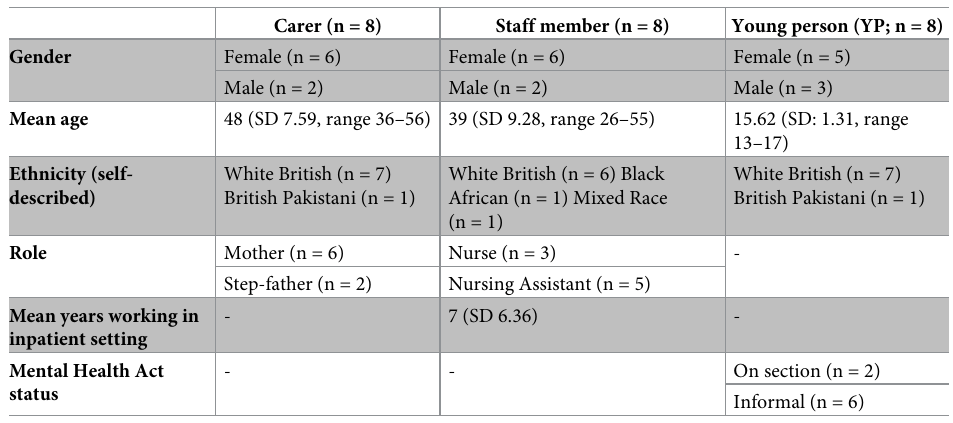
Table 1. Participant demographic